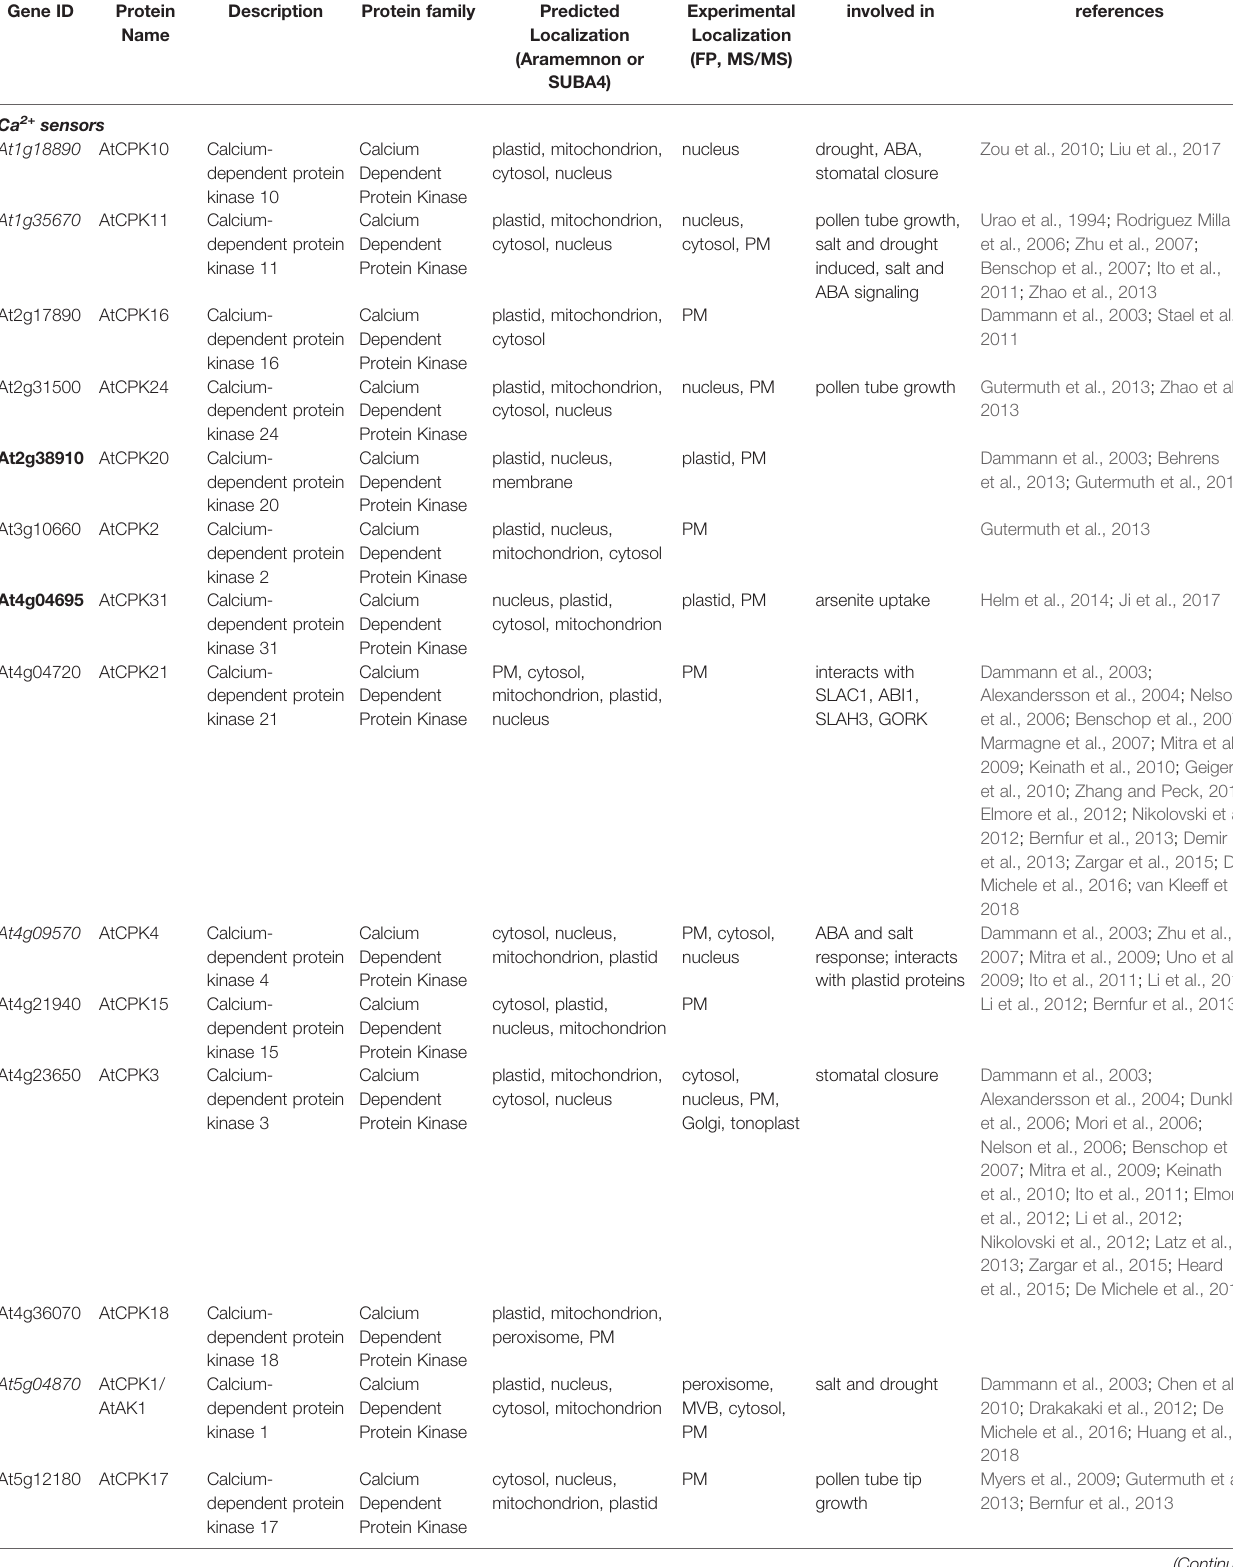
TABLE 1 | List of proteins involved in Ca 2+ handling predicted to be located in plastids. Gene